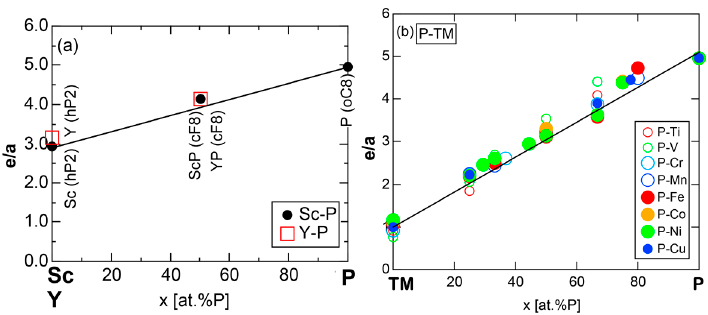
Figure 74. Composition dependence of e/a for intermetallic compounds and pure elements in ( a ) Sc-P and Y-P and ( b ) TM-P (TM=Ti to Cu) alloy systems [11]. The linear interpolation rule holds well in ( a , b ).